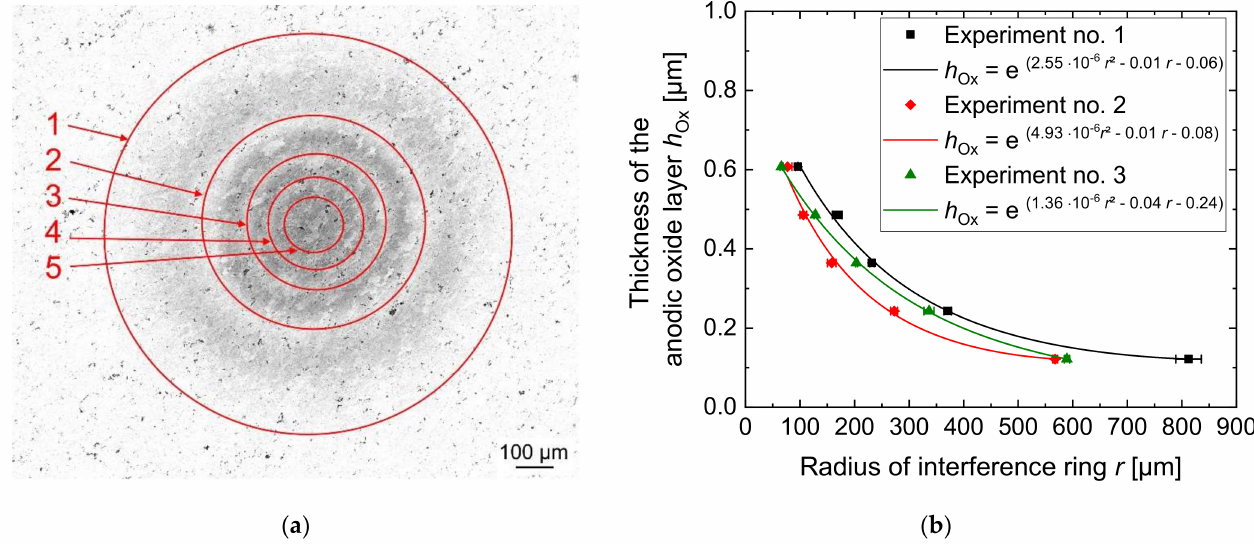
Figure 9. Optical evaluation of the local anodic oxides by laser intensity images with marked interference rings ( a ) and thickness characteristic of the anodic oxide as a function of the radius of the interference rings ( b ) after jet-based anodization. Linear trends indicate exponential interpolations considering radial distances within µ m